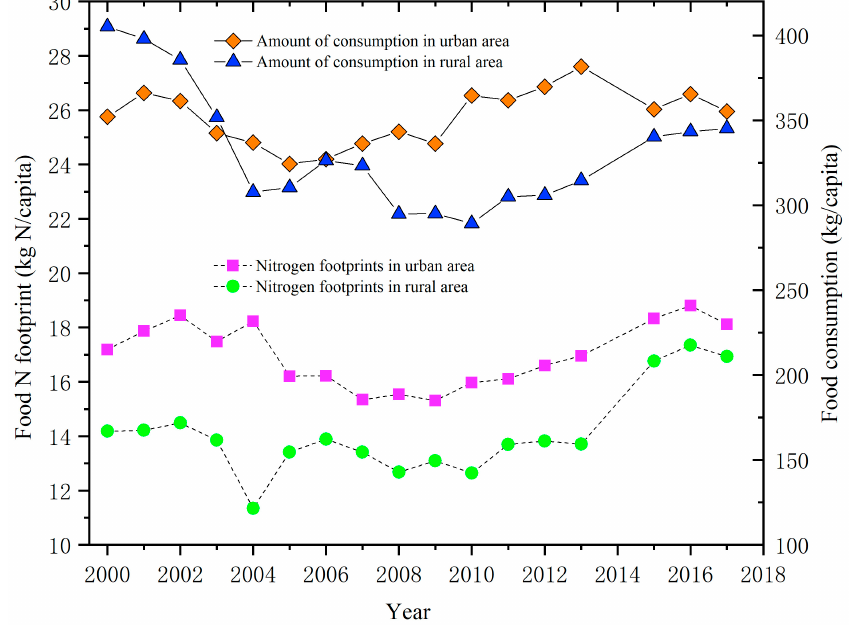
Figure 3. Variation in food consumption and N footprints per capita of Shanghai residents from 2000 to 2017.